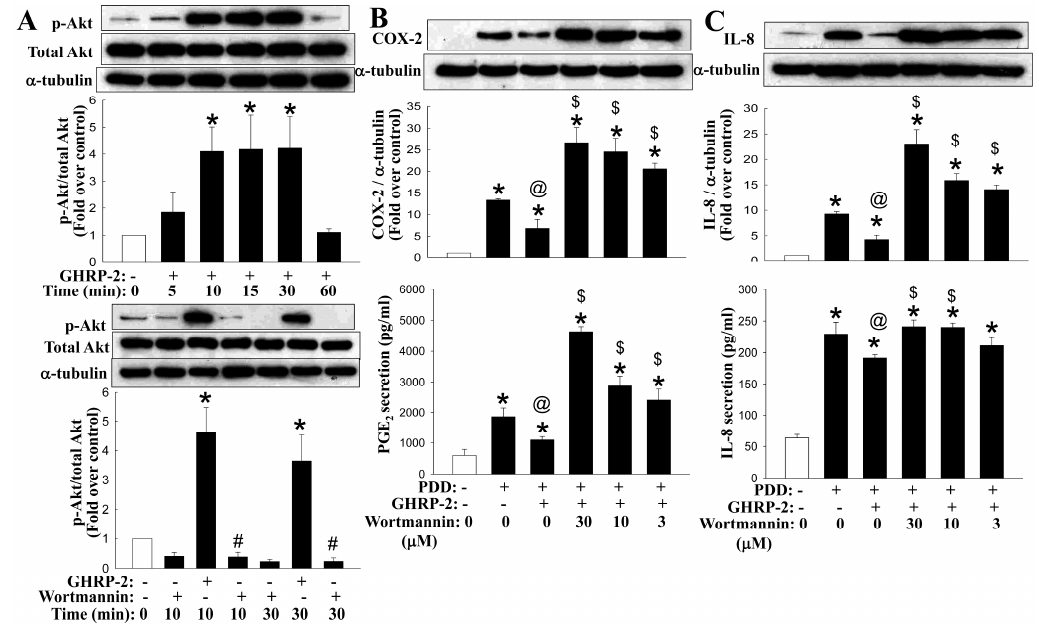
Figure 11. Involvement of the PI3K-Akt pathway in regulation by GHRP-2 of the PKC-mediated production of COX-2 and IL-8. ( A ) To examine whether Akt is under GHRP-2 regulation, plated KGN cells were treated with to GHRP-2 (1 µM) alone for 5, 10, 15, 30 or 60 min or with GHRP-2 in combination with wortmannin (10 µM) for 10 or 30 min. The Akt phosphorylation was monitored by Western blotting assay. ( B , C ) To evaluate the role of Akt in the GHRP-2 regulation of PKC-induced inflammation, plated KGN cells were pretreated with GHRP-2 (1 µM) alone or in combination with the PI3K-Akt inhibitor wortmannin (3, 10, and 30 µM) for 2 h, and then PDD (100 nM) was included for an additional 12 h. The intracellular COX-2 ( B ) and IL-8 ( C ) protein expression levels and the resulting PGE 2 ( B ) and IL-8 ( C ) concentrations in the cultured media were determined by Western blotting assay and ELISA, respectively. The results are expressed as means ± SEM. (( A ): n = 3; ( B , C ): n = 4). * p < 0.05 compared with the control treatment; # p < 0.05 compared with the GHRP-2 treatment group at the same time point; @ p < 0.05 compared with the PDD treatment; $ p < 0.05 compared with the combined GHRP-2 and PDD treatment.